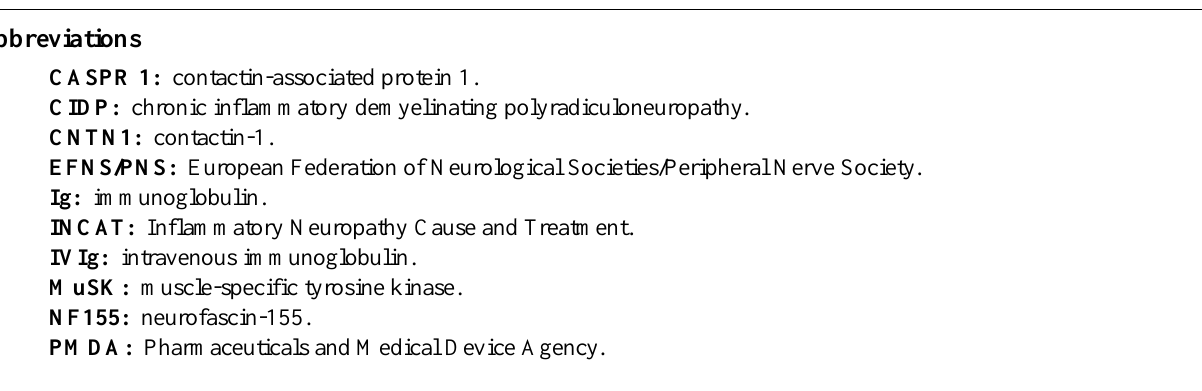
CASPR 1: contactin-associated protein